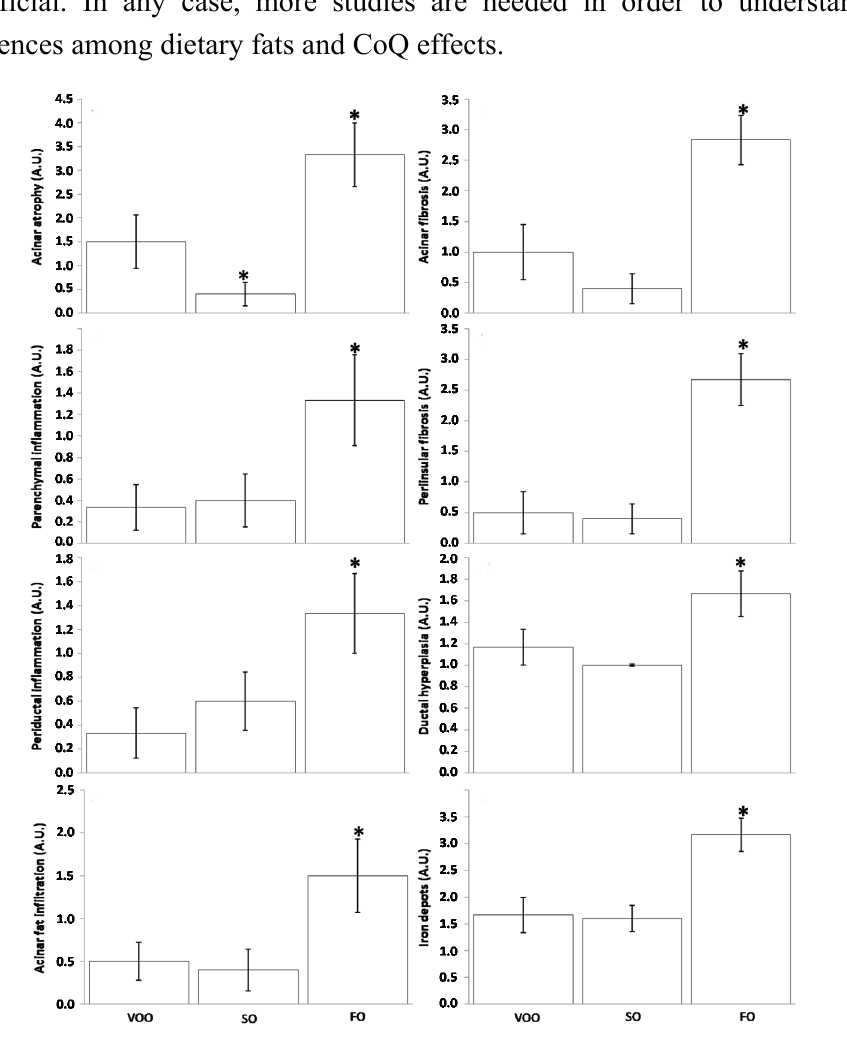
Figure 3. Data from histological evaluations of pancreas from rats fed on different dietary fat sources supplemented with Coenzyme Q: virgin olive (VOO), sunflower (SO) and fish oil (FO). Data are presented as mean ± SEM. A.U. = arbitrary units. * p < 0.05 in respect to VOO fed